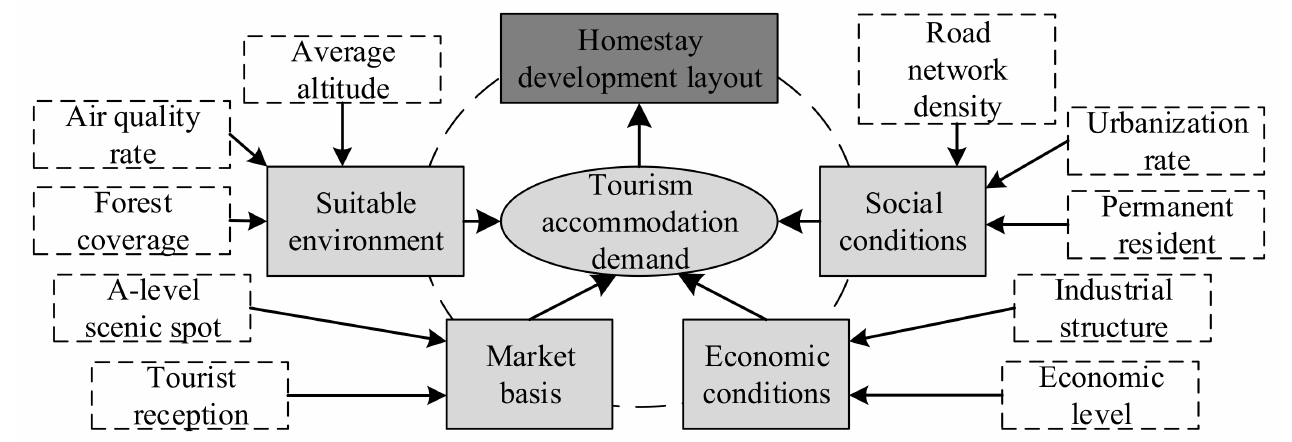
Figure 2. Impact analysis framework of homestay layout in